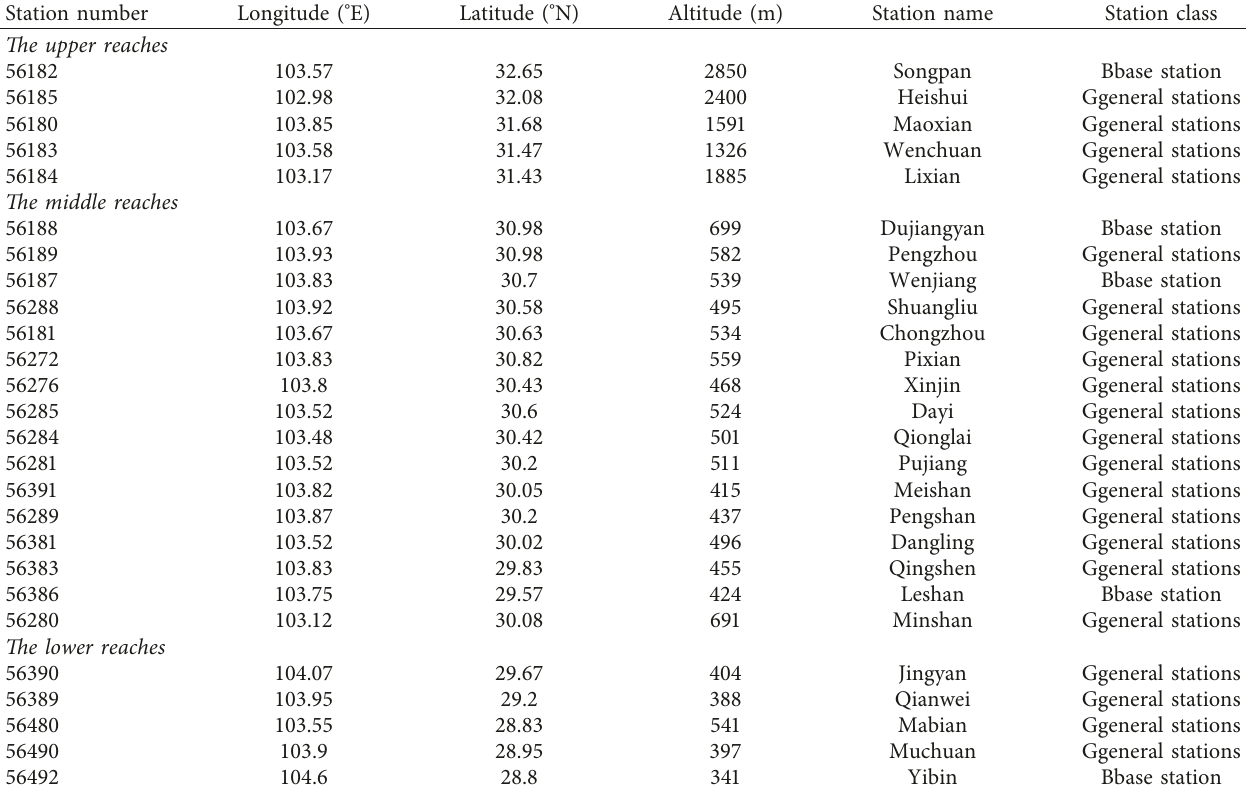
Table 1: Basic information of the meteorological stations in the Minjiang River Basin. Station